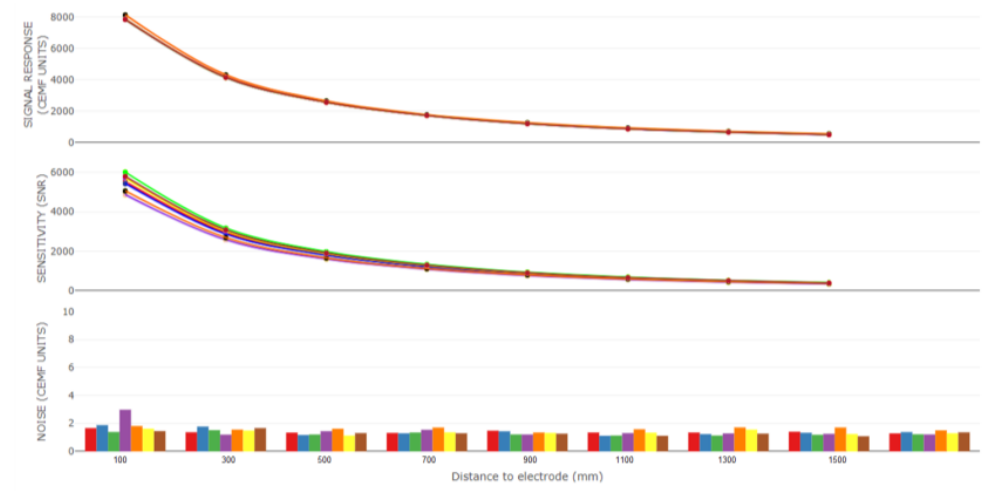
Figure 6. CEMF characterization.